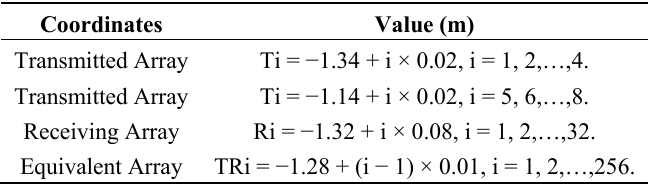
Table 1. Cross-track coordinates of array